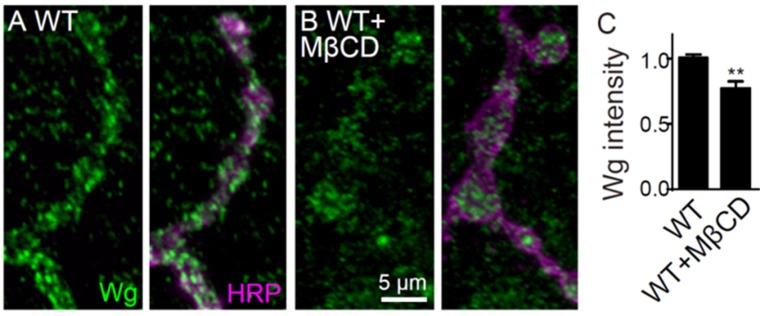
Additional NMJ images and quantifications.Images of NMJ4 co-labeled for anti-HRP (green) and anti-CSP (magenta) in nSyb-Gal4/UAS-brn (A), UAS-Wg-HA/+; nSyb-Gal4/UAS-brn (B), wild type treated with 20 mM MβCD (C), UAS-Wg-HA/+; nSyb-Gal4/+ treated with 20 mM MβCD (D), arrk0813/+ (E), arrk0813/arr2 (F), egh62d18/+; arrk0813/+ (G), evi2/+ (H), evi2 (I), and egh62d18/+; evi2/+ (J). Scale bar: 10 μm. (K) Quantification of bouton number and bouton size of NMJs. n ≥ 12 larvae; ns, no significance, *p<0.05; **p<0.01 and ***p<0.001 by one-way ANOVA with Tukey post hoc tests, error bars: s.e.m. (L and M) Representative images of NMJ4 co-labeled with anti-Wg (green) and anti-HRP (magenta) in wild type (L) and wild type treated with 20 mM MβCD (M). Scale bar: 5 μm. (N) Quantification of Wg intensity normalized to HRP intensity. n ≥ 15 larvae; ns, no significance; **p<0.01 by student’s t test; error bars: s.e.m.